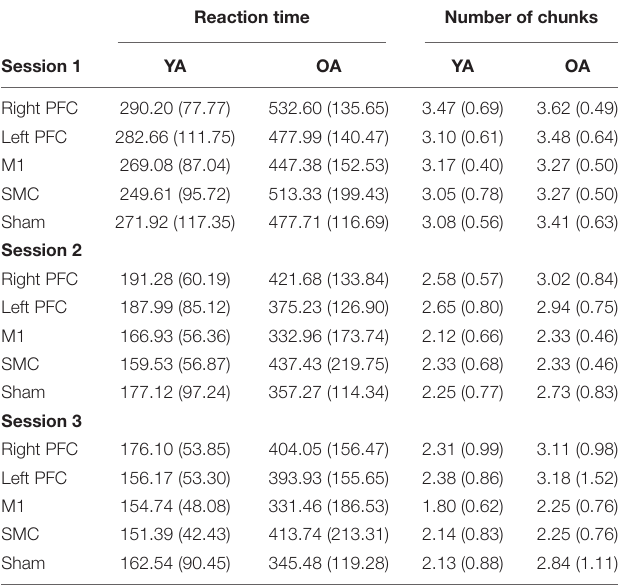
TABLE 4 | Means (SD) of reaction time and number of chunks for each stimulation group, age group, and session. Reaction time Number of